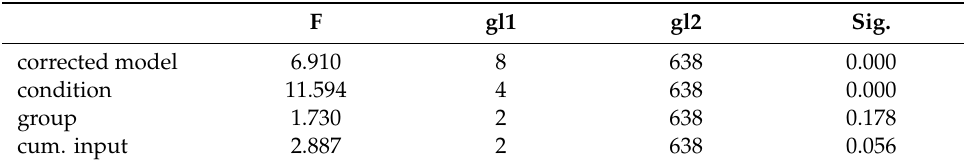
Table 3. Generalized linear mixed model (GLMM) results, all test conditions included. F gl1 gl2 Sig.